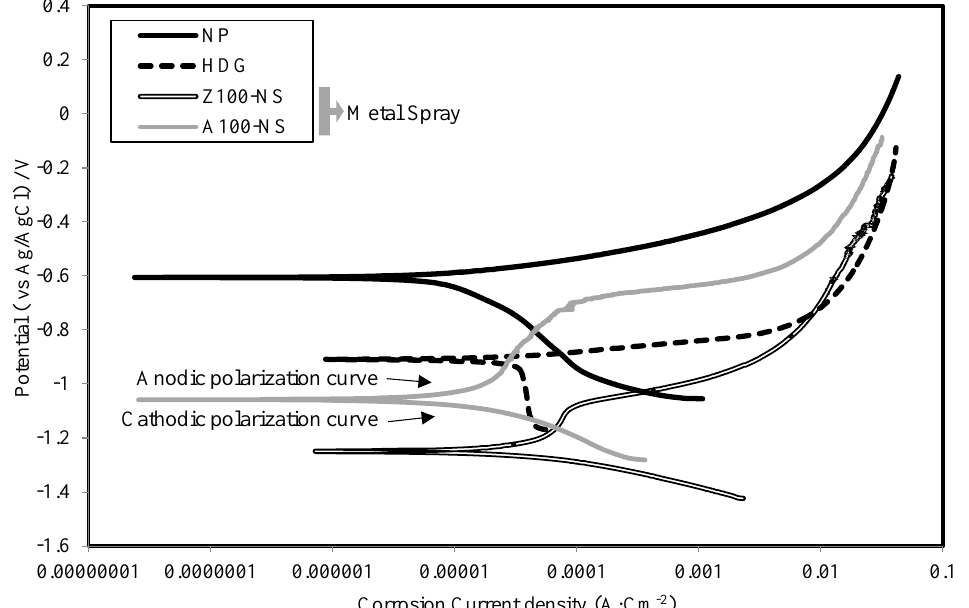
Figure 7. Polarization curves of Z73-A27 with and without epoxy sealing